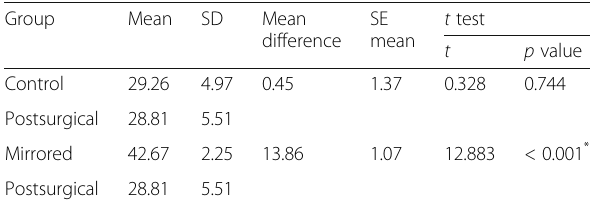
Table 3 Comparison between the postsurgical group and both control and mirrored groups